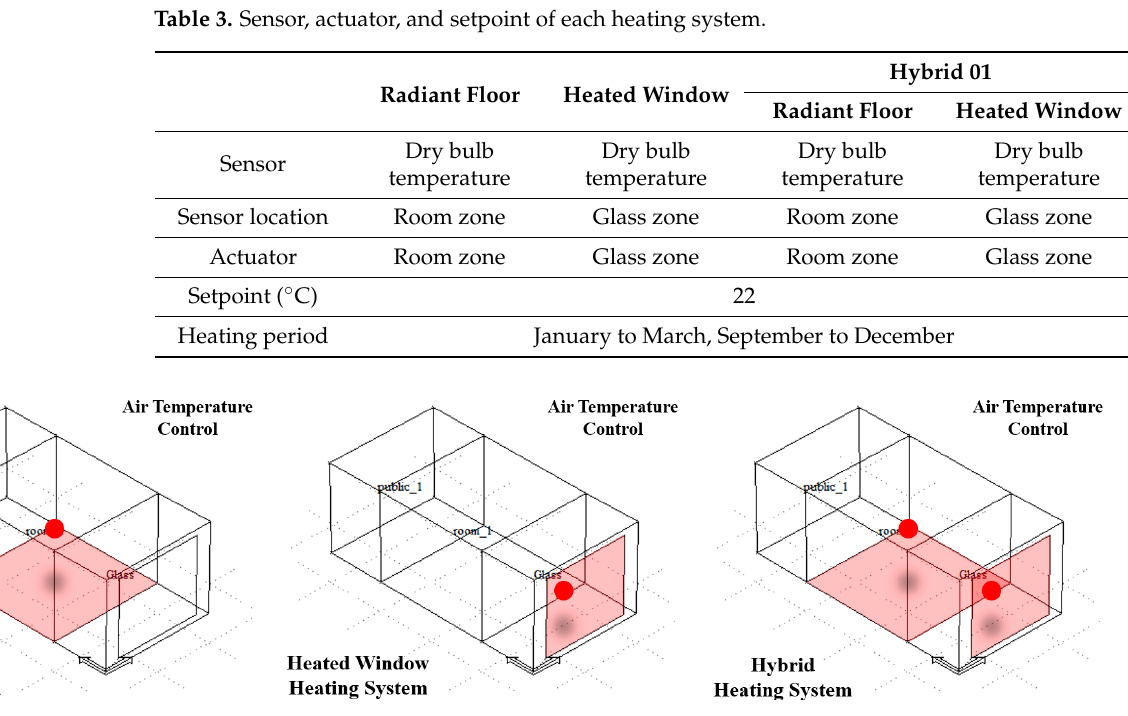
Figure 3. Heating surface and air temperature sensing point of each heating system. Table 3. Sensor, actuator, and setpoint of each heating system.